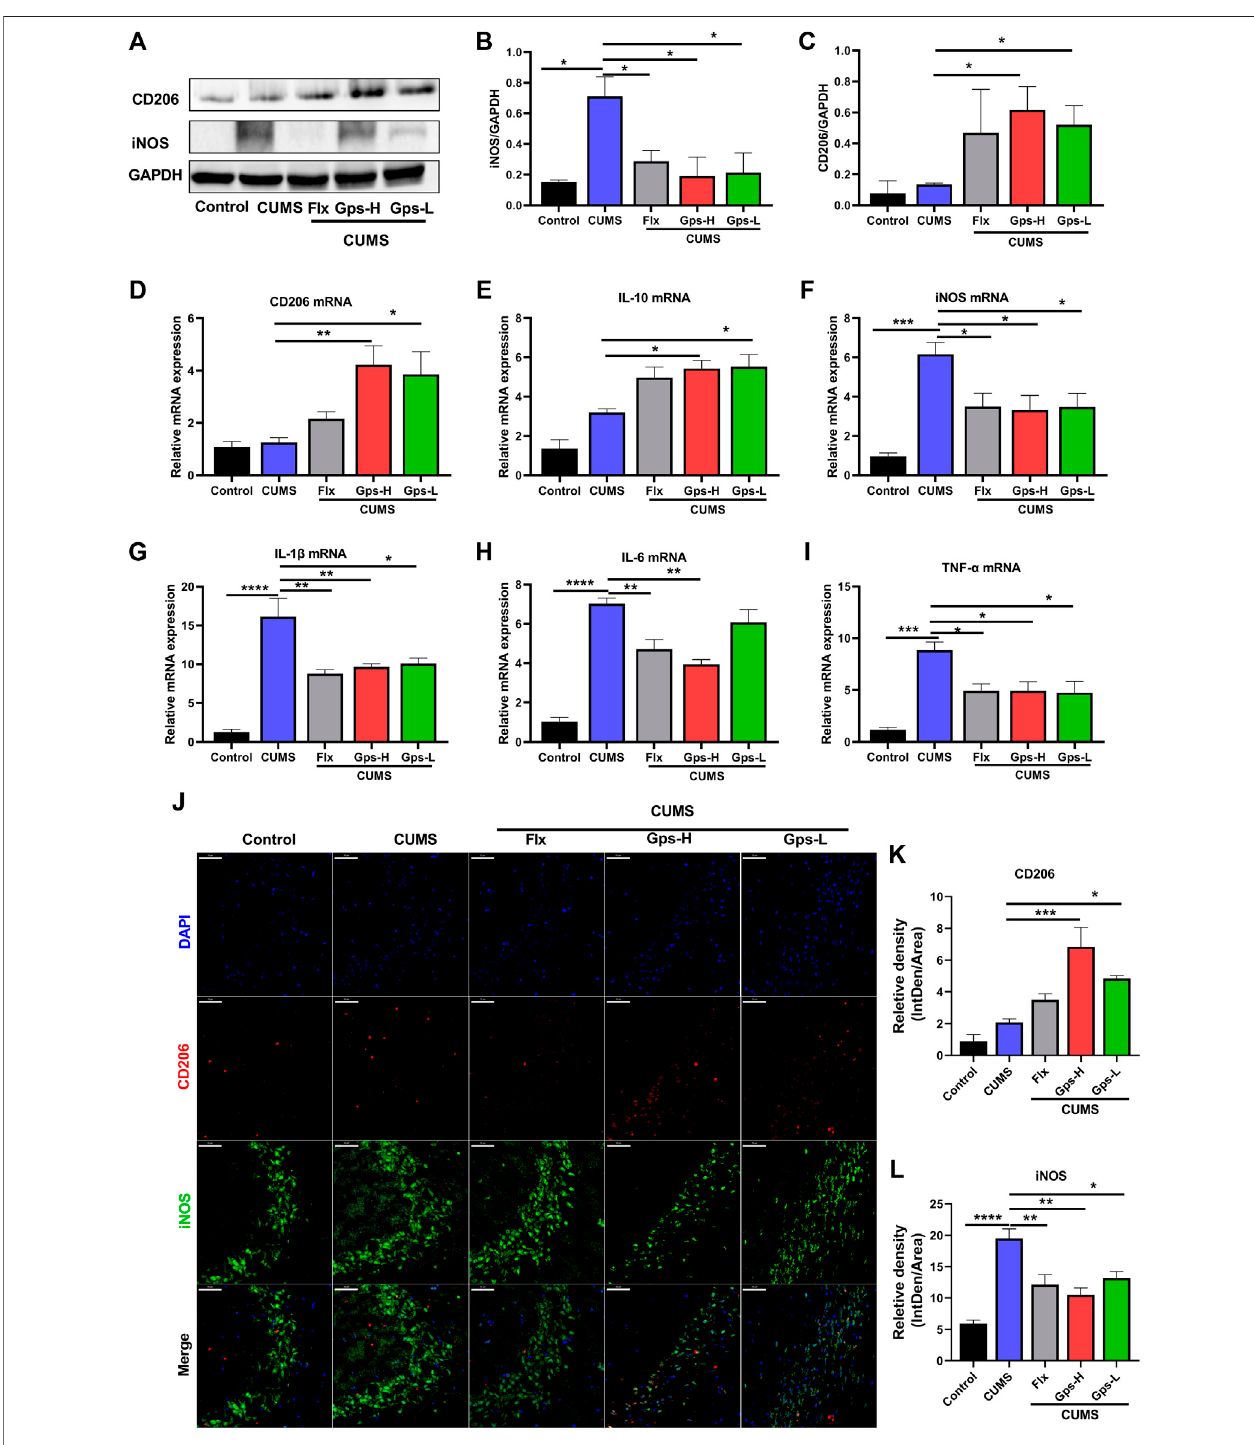
FIGURE 6 | Gps regulates microglial state transition in CUMS-exposed mice. (A) . Representative immunoreactive bands showing the hippocampal iNOS and CD206 protein levels in the control (untreated), CUMS, Flx + CUMS, Gps-H + CUMS, and Gps-L + CUMS mice. (B,C) Statistical results showed that CUMS stress increased the expression of iNOS proteins in the hippocampus, while Gps inhibited the effects of CUMS and promoted the expression of CD206 protein. (D – I) The expressionofCD206,IL-10,iNOS,IL-1 β ,IL-6,andTNF- α mRNAwasdeterminedusingqPCRinthecontrol(untreated),CUMS,Flx+CUMS,Gps-H+CUMS,and Gps-L+CUMSmice. (J) .Representativeimmuno fl uorescenceimagesofiNOS(green)andCD206(red)inthecontrol(untreated),CUMS,Flx+CUMS,Gps-H+CUMS, and Gps-L + CUMS mice (× 400 magni fi cation). Scale bar indication 50 µm. (K,L) . The relative fl uorescence intensity of CD206 and iNOS in the control (untreated), CUMS,Flx+CUMS,Gps-H+CUMS,andGps-L+CUMSmice.ThevaluesofiNOSandCD206wereexpressedbyIntDen/Areaindifferentgroupsandareshownonthe y-axis. The results were expressed as mean ± SEM. n = 3 for each group. *, p < 0.05; **, p < 0.01; ***, p < 0.001; ****, p < 0.0001 vs. CUMS.